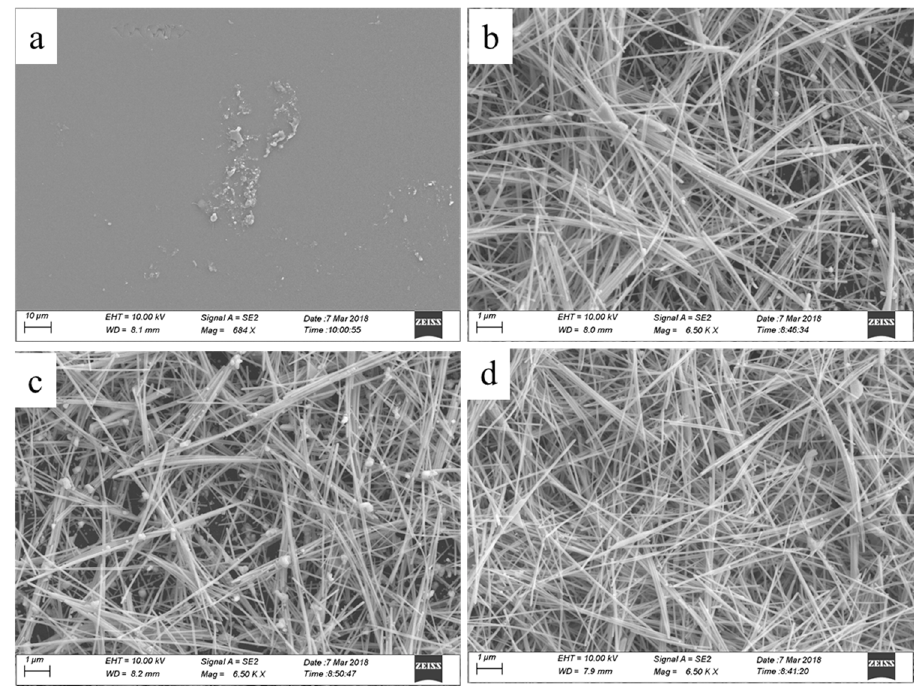
Figure 7. SEM images of AgNWs coatings with different coating layers, ( a ) pure photographic paper, ( b ) 2, ( c ) 4, ( d ) 7 coating layers, respectively.